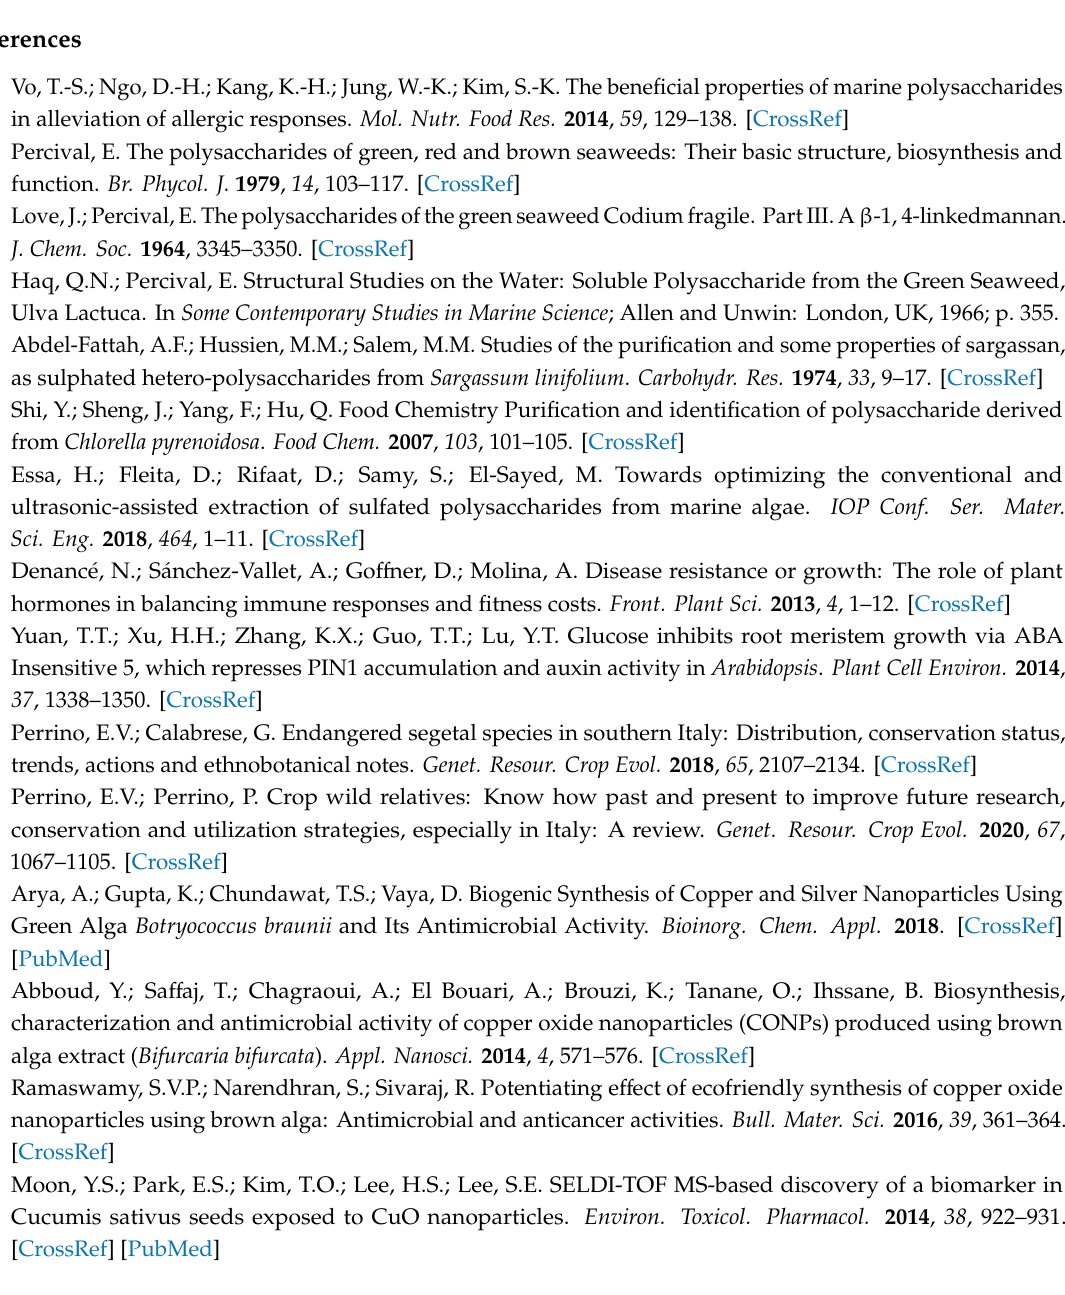
Table S1 Constituents of sugars calculated as area percentage from the total chromatogram of HPLC. Figure S1 HPLC chromatogram of